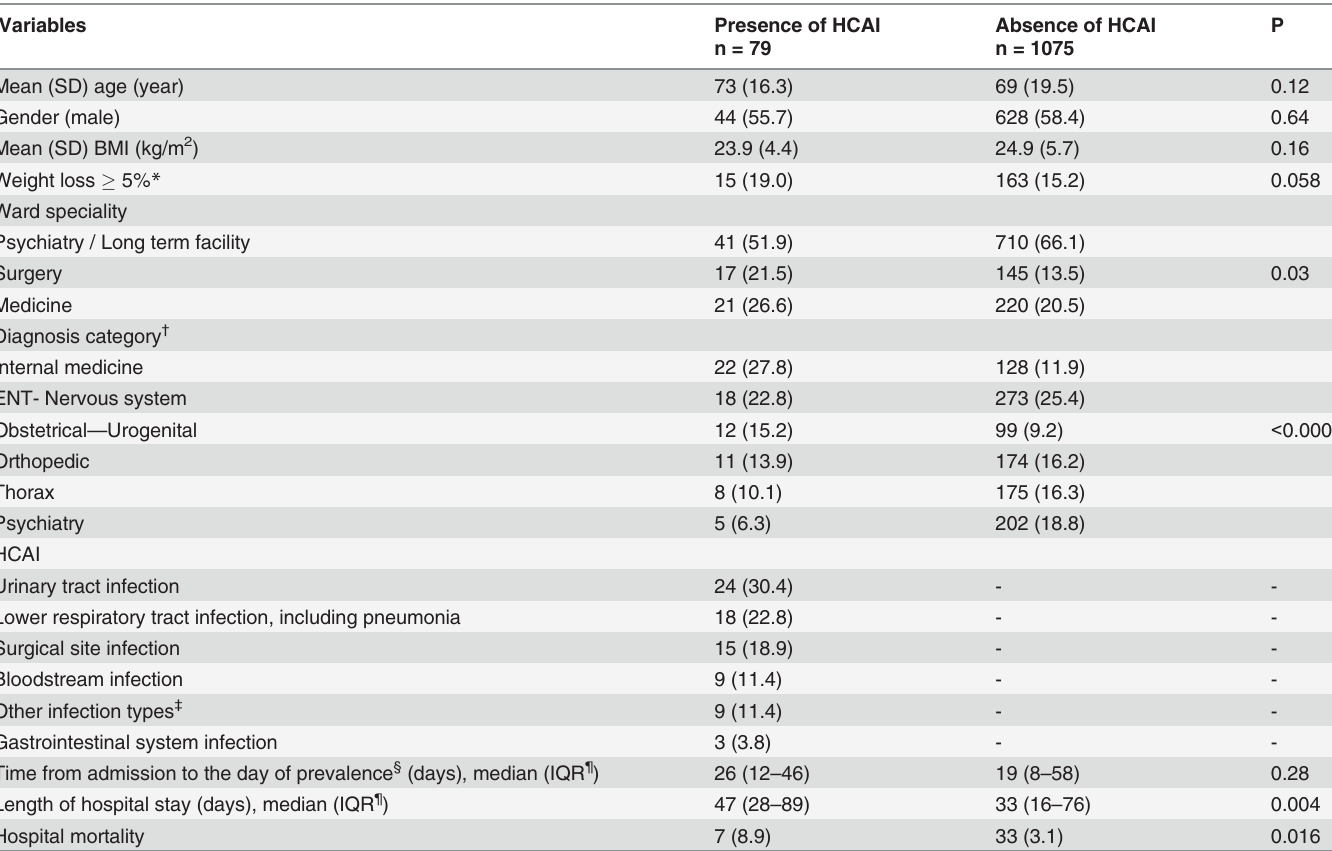
Table 1. Patient characteristics and clinical diagnoses, according to the presence or absence of healthcare-associated infections